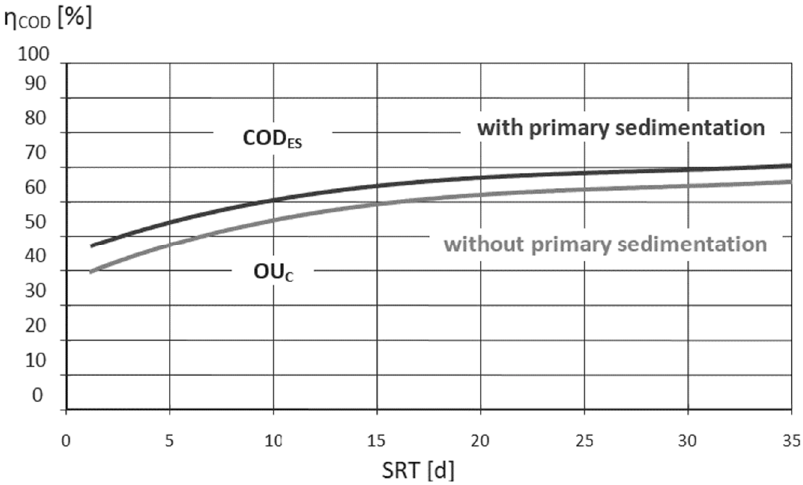
Figure 1. COD in excess sludge (COD ES ) and the oxygen utilisation for carbon removal (OU c ) in correlation to the SRT [4]